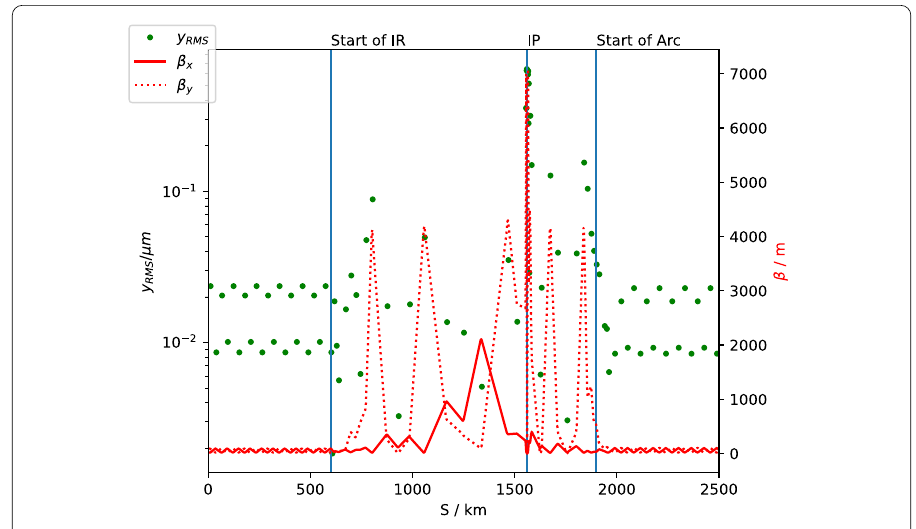
Figure 11 Rms closed orbit due to 10 nm vertical misalignment of single quadrupoles around the IP (left axis), plotted on the same figure as horizontal and vertical β functions (right axis). The interface between the IRs and the arcs and the interaction point are marked on the plot